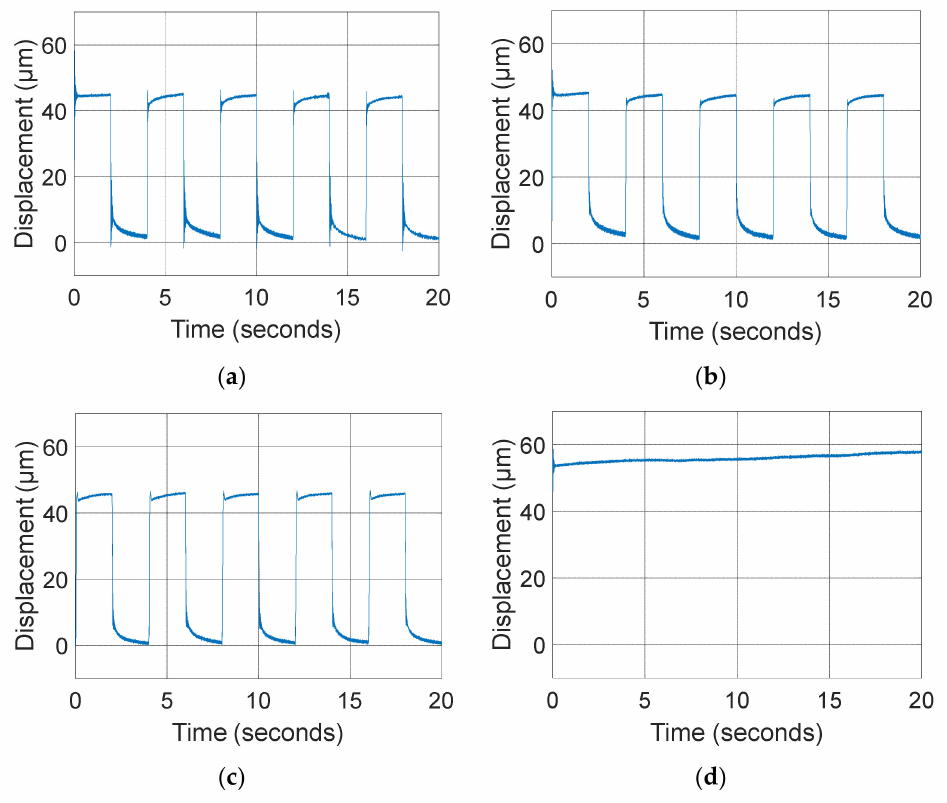
Figure 7. LQR closed-loop experimental response when varying R when Q = 70,000; ( a ) R = 1; ( b ) R = 0.1; ( c ) R = 0.01; and, ( d ) R =